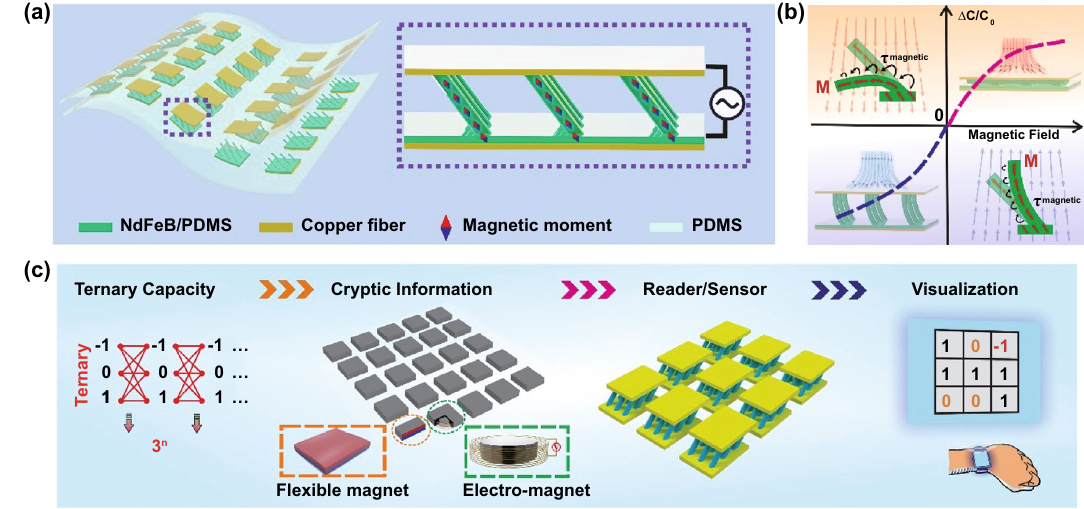
Fig. 1 a Structure and magnetic property design of the flexible magnetic field sensor based on t-FMA. b Working mechanism of the flexible magnetic field sensor. M and τ magnetic represent the magnetic moment vector and magnetic torque, respectively. c Schematic of encoding, decod- ing and extraction of the targeted information based on our proposed touchless and cryptic information recognition